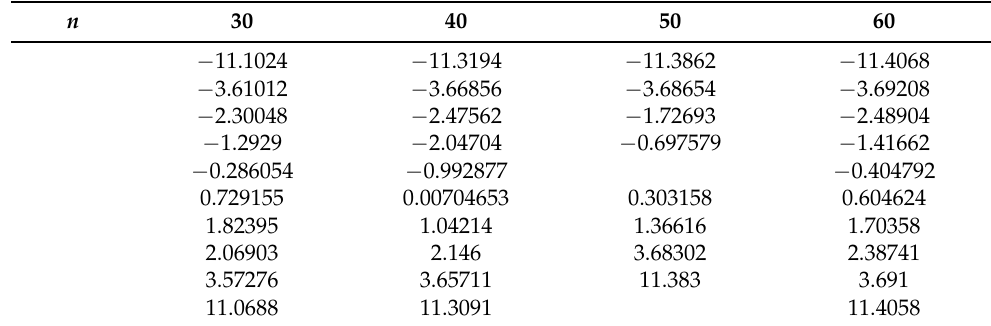
Table 1. Approximate real zeros of C S n ,0.9,0.8 ( x ,2 ) .